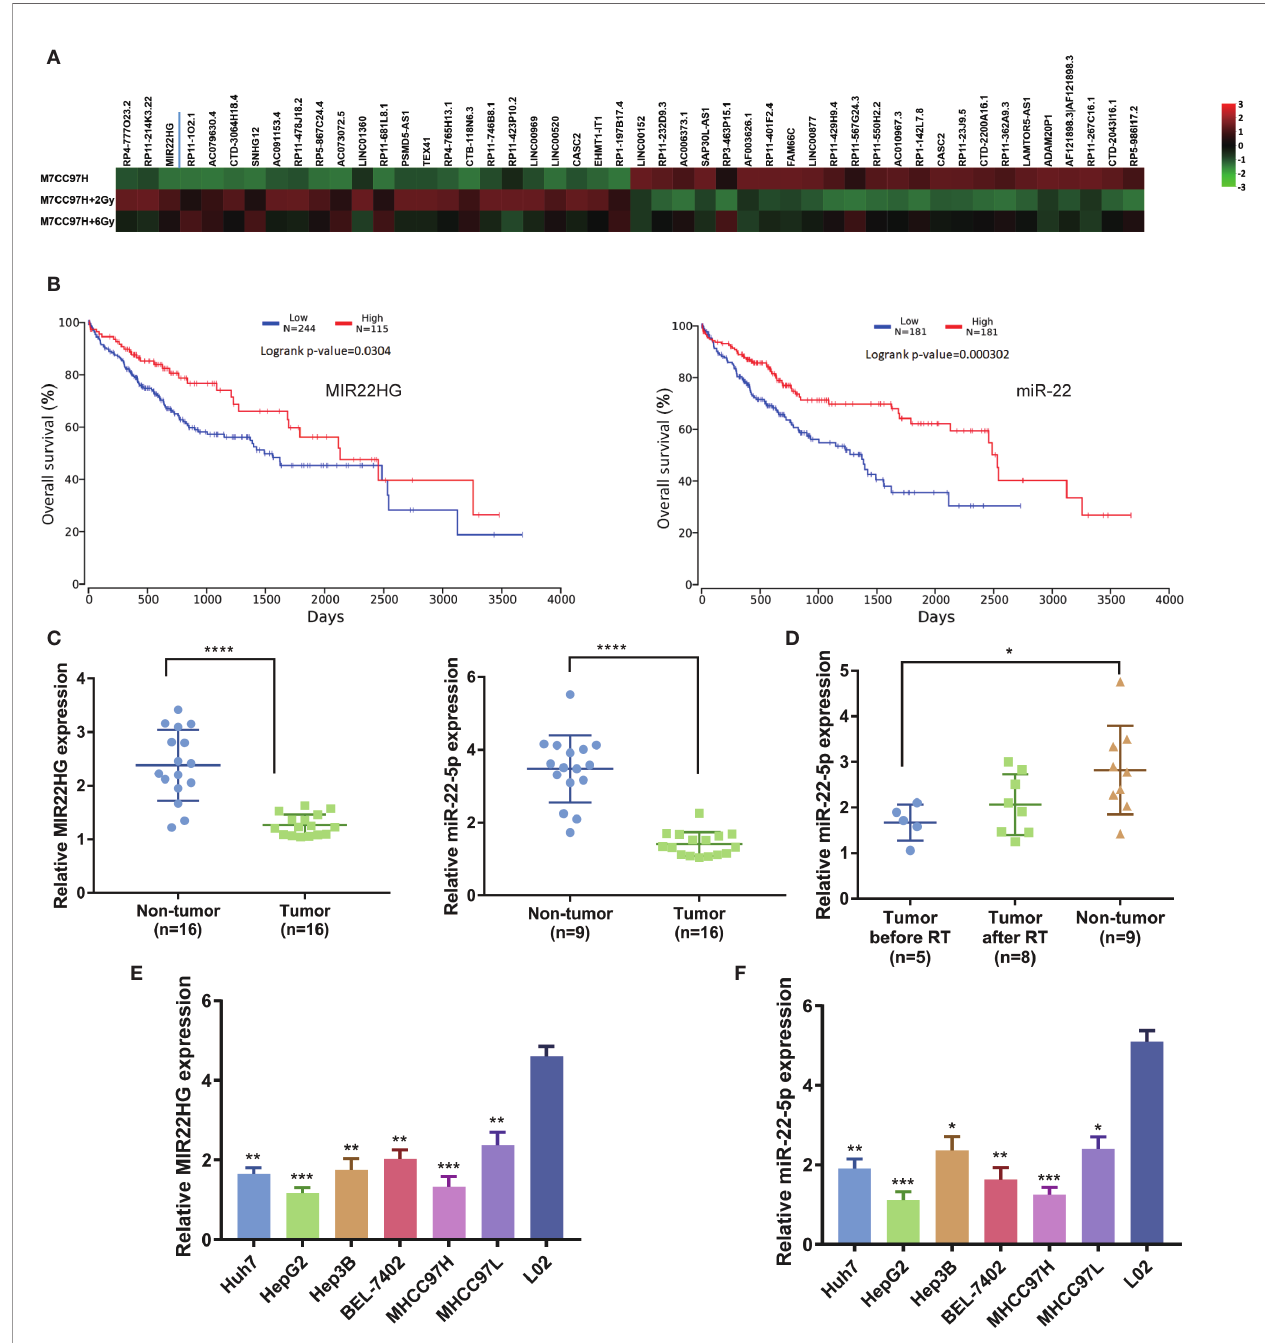
FIGURE 1 | (A) Microarray results indicating that MIR22HG expression in MHCC97H cells increased signi fi cantly after irradiation. (B) Kaplan-Meier curves of the overall survival. The P -value was computed using the log-rank test. (C) mRNA expression of MIR22HG and miR-22-5p in tumor (n = 16) and non-tumor (n = 16) tissue. (D) miR-22-5p expression in blood samples of healthy individuals and patients with HCC before and after radiotherapy. (E, F) mRNA expression of MIR22HG and miR-22-5p in HCC cells Huh7, HepG2, Hep3B, BEL-7402, MHCC97H, and MHCC97L and in the human normal liver cell L02. *Compared with the L02 group. Mean ± SD (n = 3 independent experiments). * p < 0.05, ** p < 0.01, *** p < 0.001, **** p <